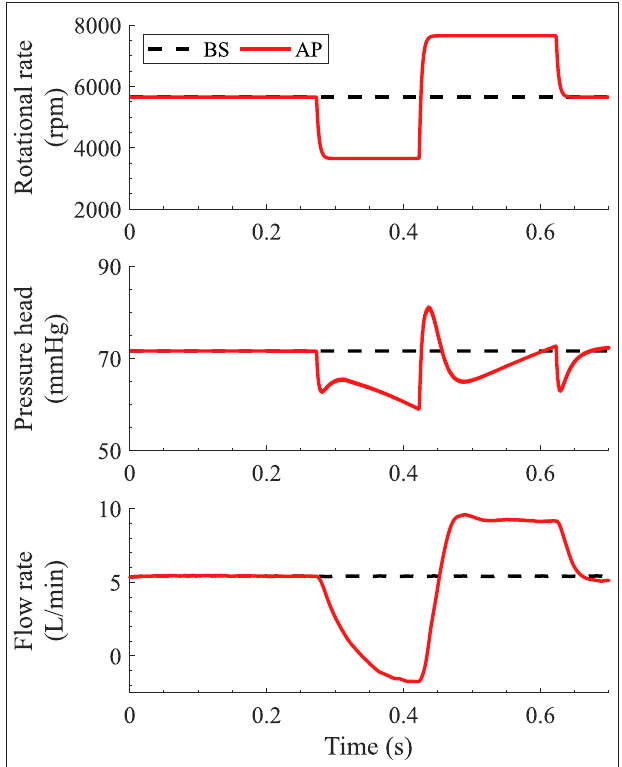
FIGURE 2 | Pump rotational speed (A) , pump pressure head (B) and pump flow rate (C) during the artificial pulse and under baseline conditions. The pump pressure head associated with the different conditions was obtained from the lumped parameter heart-pump interaction model as described in Simulation Scenarios and Boundary Conditions. Rotational speed and pressure head are imposed as boundary conditions in the computational fluid dynamics (CFD) simulations, while the pump flow rate is a result of the CFD